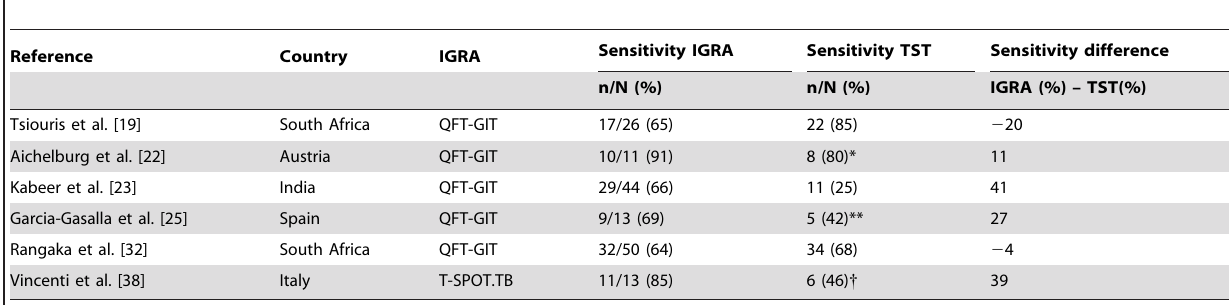
Table 3. Head-to-head comparison of sensitivity between IGRAs and TST in HIV-infected patients with culture-confirmed